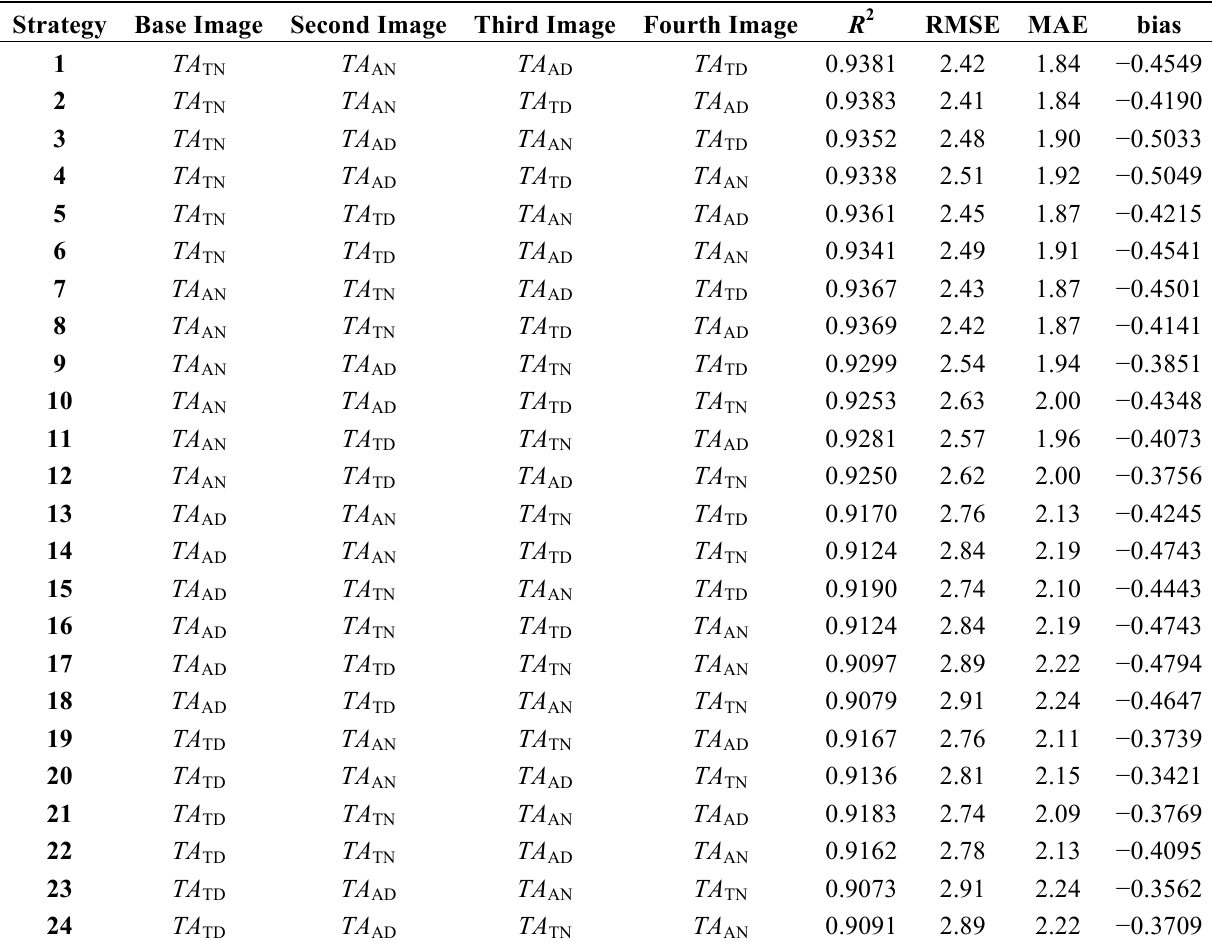
Table 6. Possible image merging strategies to create maps of daily mean air temperature ( TA ) using the TERRA and AQUA MODIS land surface temperatures (LSTs) and their accuracy using the validation datasets from 2012 to